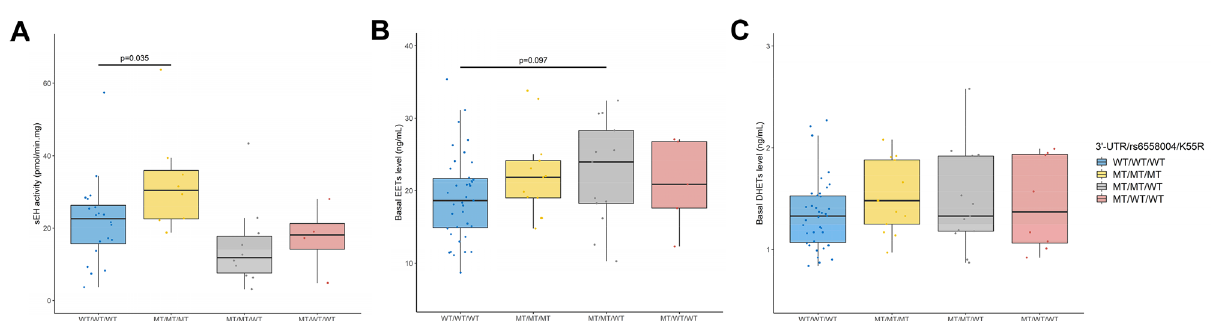
Figure 4. Impact of the haplotype construction of 3 ′ UTR, rs65598004 and K55R polymorphisms on soluble epoxide hydrolase (sEH) activity in isolated peripheral blood mononuclear cells ( A ), baseline plasma levels of epoxyeicosatrienoic acids (EETs; B ) and dihydroxyeicosatrienoic acids (DHETs; C ) determined at the time of the exploration visit in kidney transplant